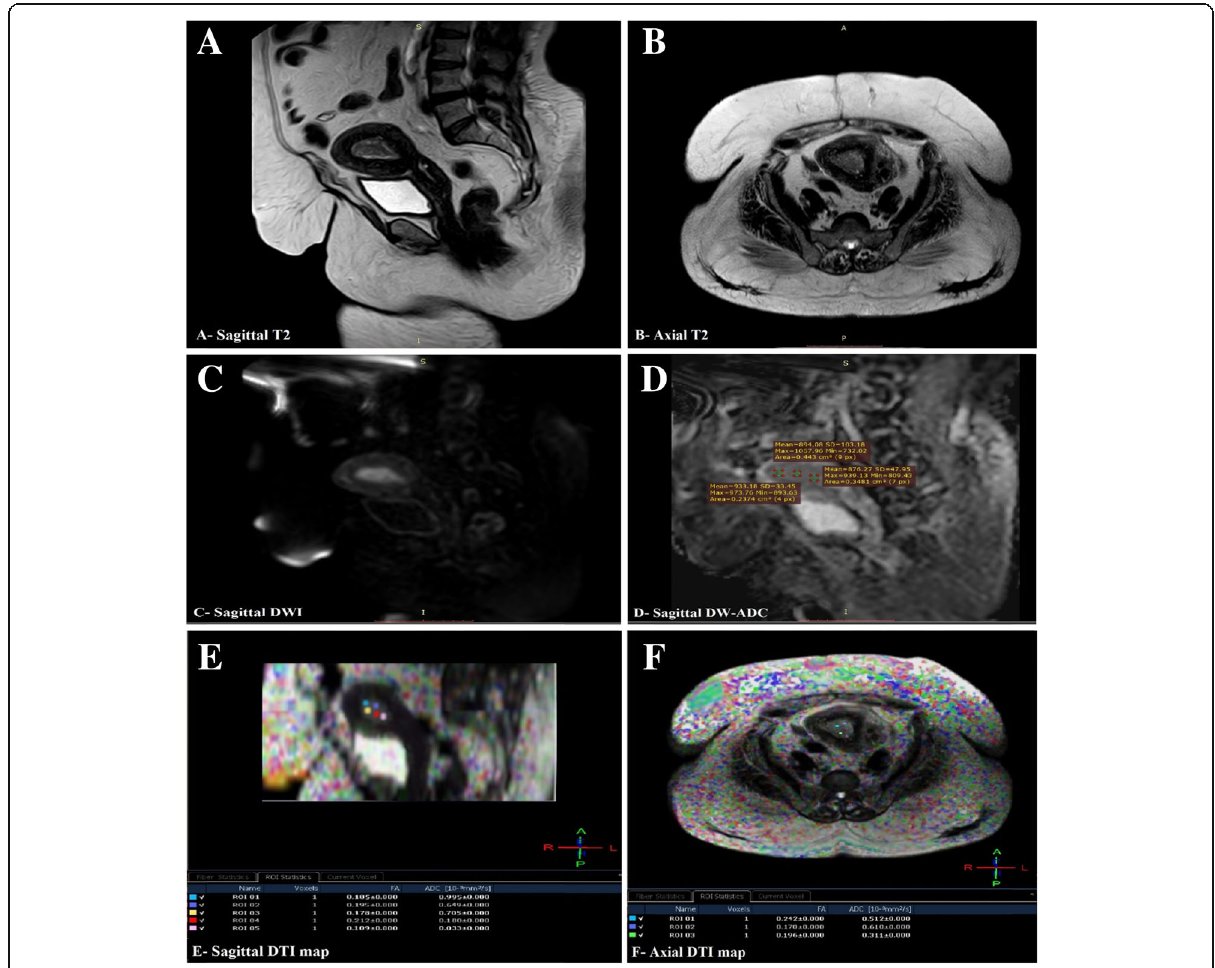
Fig. 5 A 59-year-old postmenopausal female presented by abnormal vaginal bleeding. On TVS examination, the endometrium was thick and echogenic measuring about 19 mm in diameter with relatively well-defined margins. a, b Sagittal and axial T2 WIs show irregular endometrial thickening which is occupied by a soft-tissue mass displaying intermediate SI (red stars). No visible tumor breaching through the junctional zone. No myometrial invasion or cervical extension. c Sagittal DWI with b value of 1000 s/mm 2 shows high signal intensity of the endometrial soft- tissue mass. d Sagittal DW-ADC map image shows low signal intensity of the endometrial soft-tissue mass. Mean DW-ADC value = 0.901 × 10 − 3 mm 2 /s. e , f Sagittal and axial DTI map images demonstrate values of DT-FA and DT-MD in multiple ROI along the endometrial mass. Mean DT-FA value = 0.186, and mean DT-MD value = 0.499 × 10 − 3 mm 2 /s. Diagnosis: pathologically proved endometrioid adenocarcinoma G2